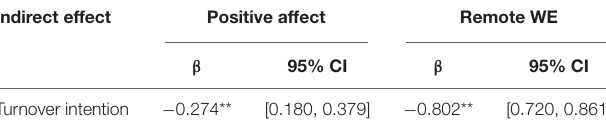
TABLE 4 | Indirect effect